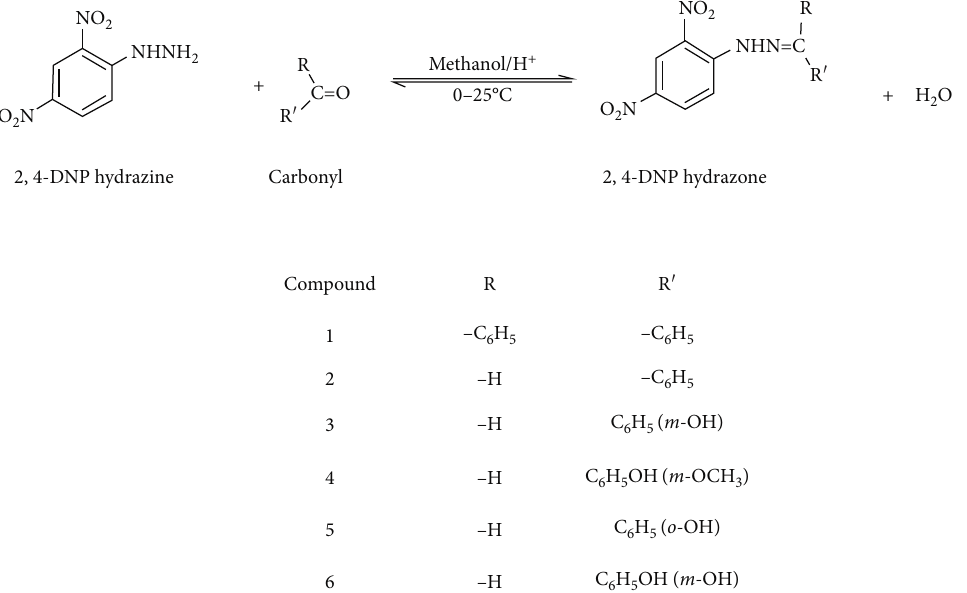
2 SO 4 (98% v/v, 2mL),